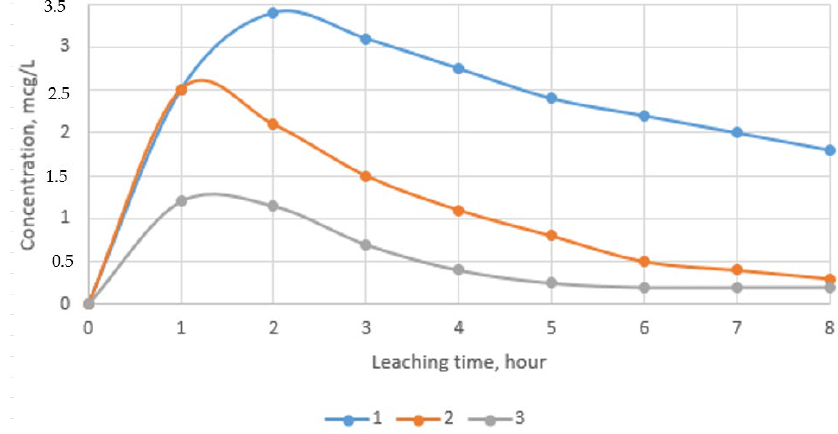
Figure 13. Kinetics of Cr 3+ extraction from bricks in various media. 1—brick with 25 wt.% spent sorbent (pH = 4); 2—brick with 25 wt.% spent sorbent (pH = 7); 3—brick without spent sorbent (pH = 4).